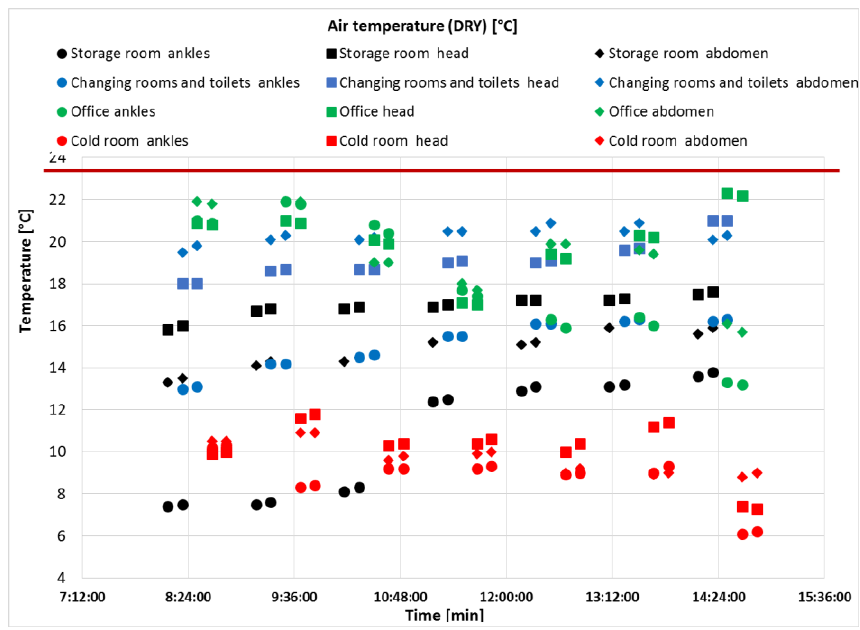
Figure 4. Air temperature measured at different height levels in the objectified locations. Legends: red horizontal line represents the average outside atmospheric temperature (ambient temperature).